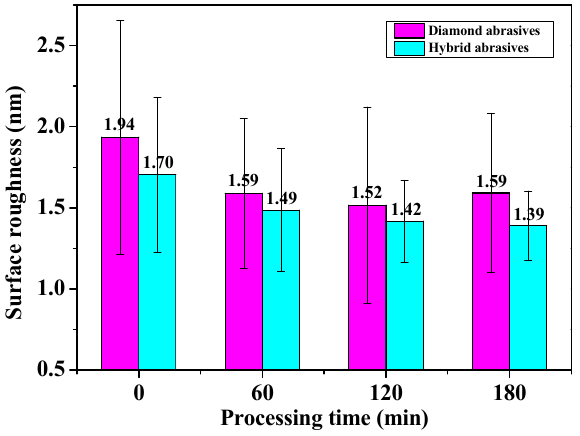
Figure 4. Roughness of sapphire substrate polished by diamond and hybrid abrasives at different processing time periods.